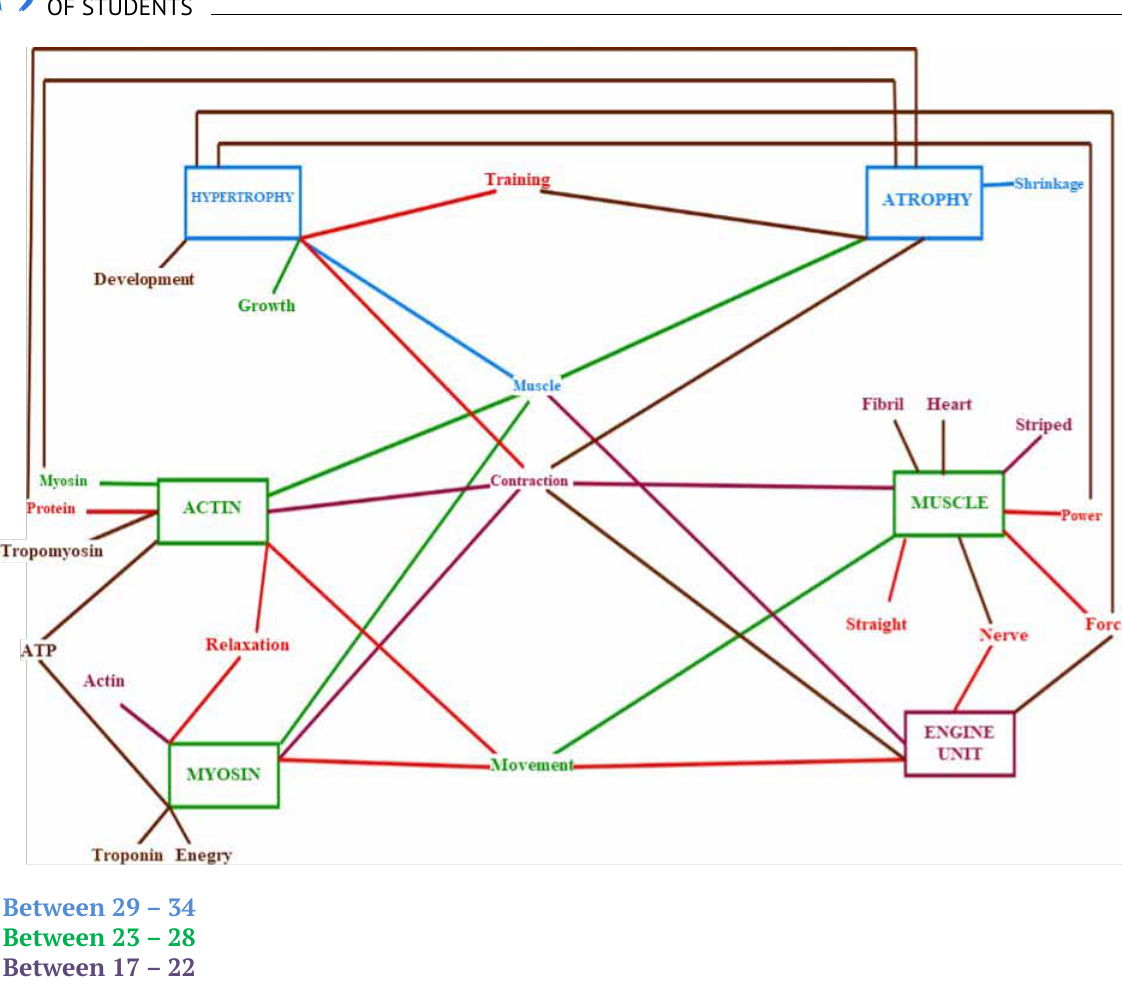
Figure 3. Concept Network Created with Second Group Keywords (Pre-Test)